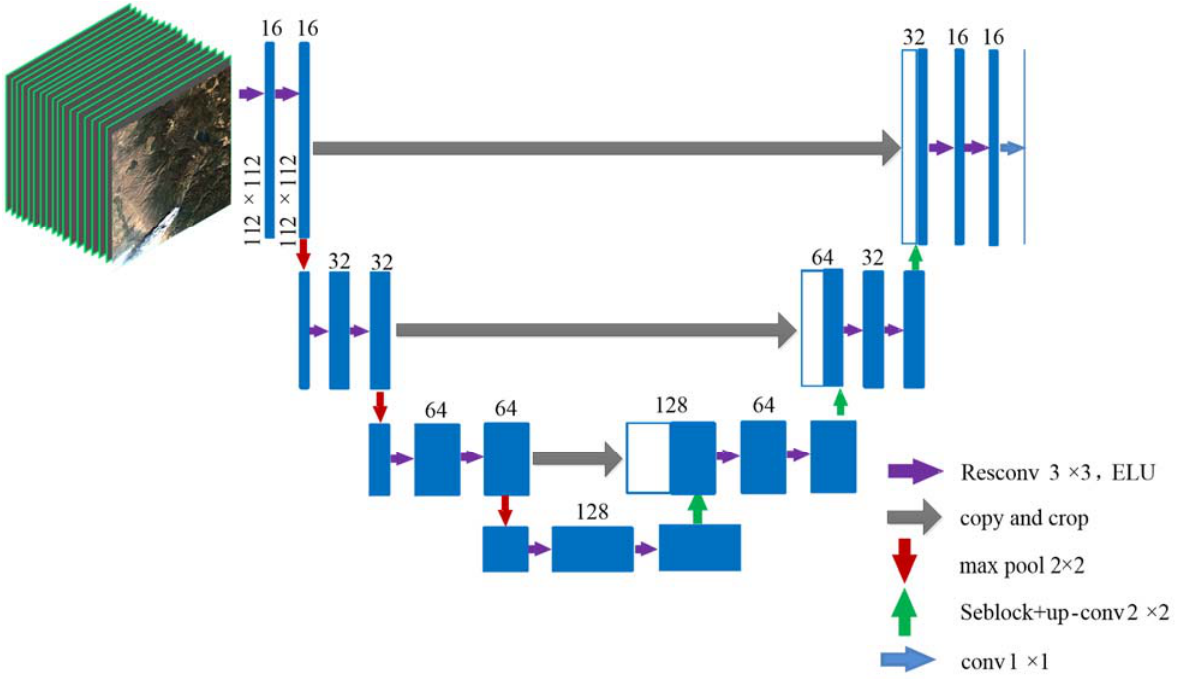
Figure 6. Smoke ‐ Unet. Figure 6.